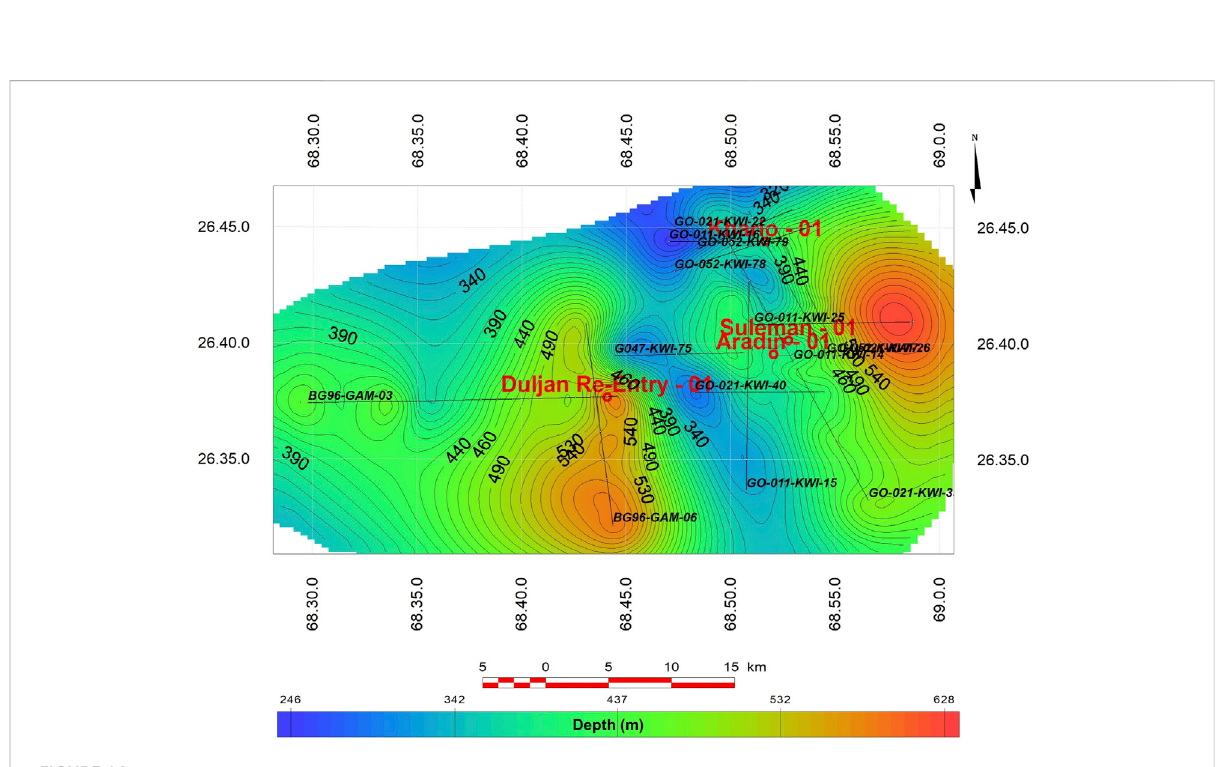
FIGURE 14 Isopach map of sands of the Sembar Formation (blue shows minimum thickness, whereas red shows maximum thickness).